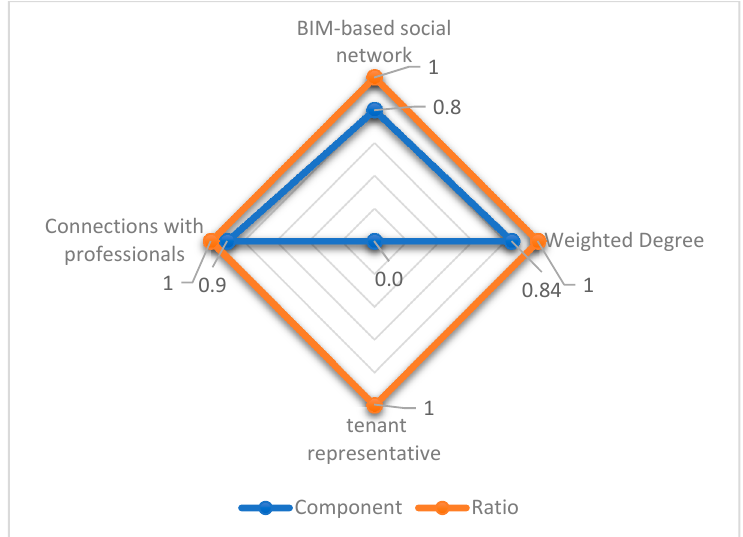
Figure 1. Graphical display of the Green BIM Index components.